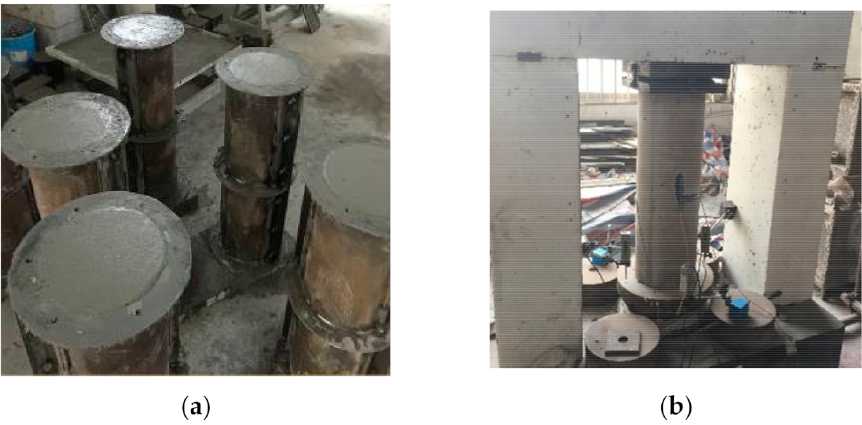
Figure 5. Unreinforced specimens. ( a ) Specimens pouring; ( b ) Completed specimen.